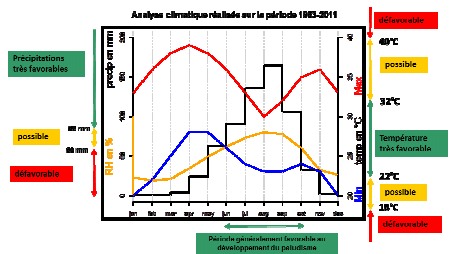
Figure 6 : Yearly climatology for the Nouna region, and climate conditions favoring